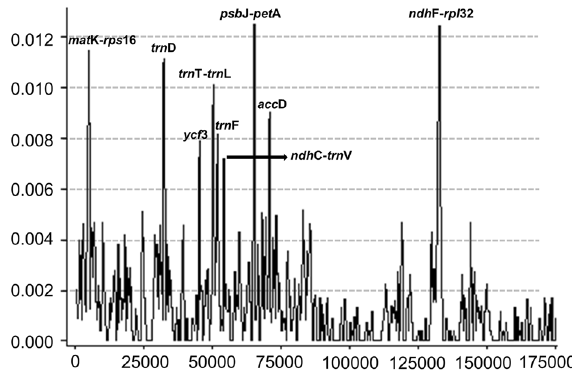
Figure 1. A correct version of the original Figure 5.